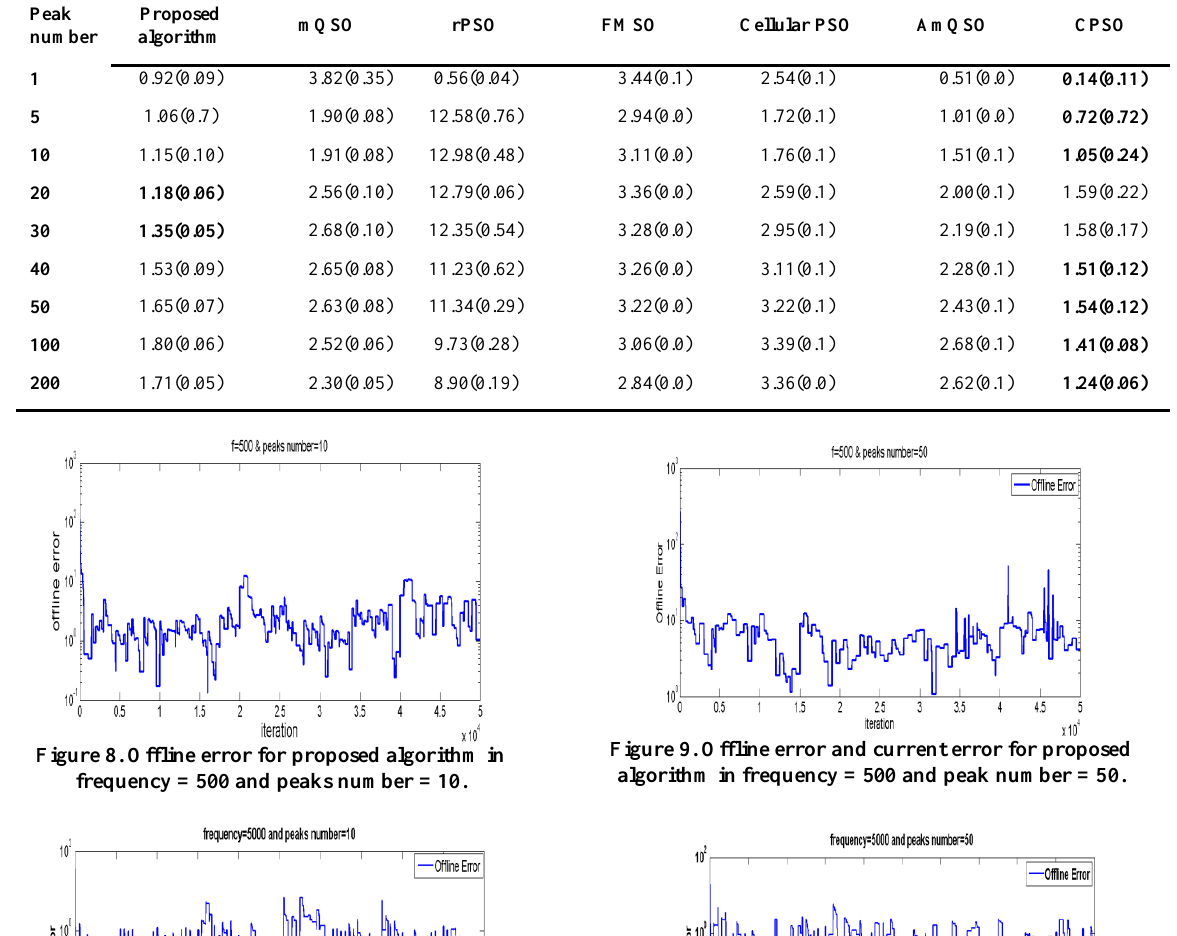
Table 5. Average offline errors for different algorithms on MPB Problem with different numbers of peaks and frequency 5000.